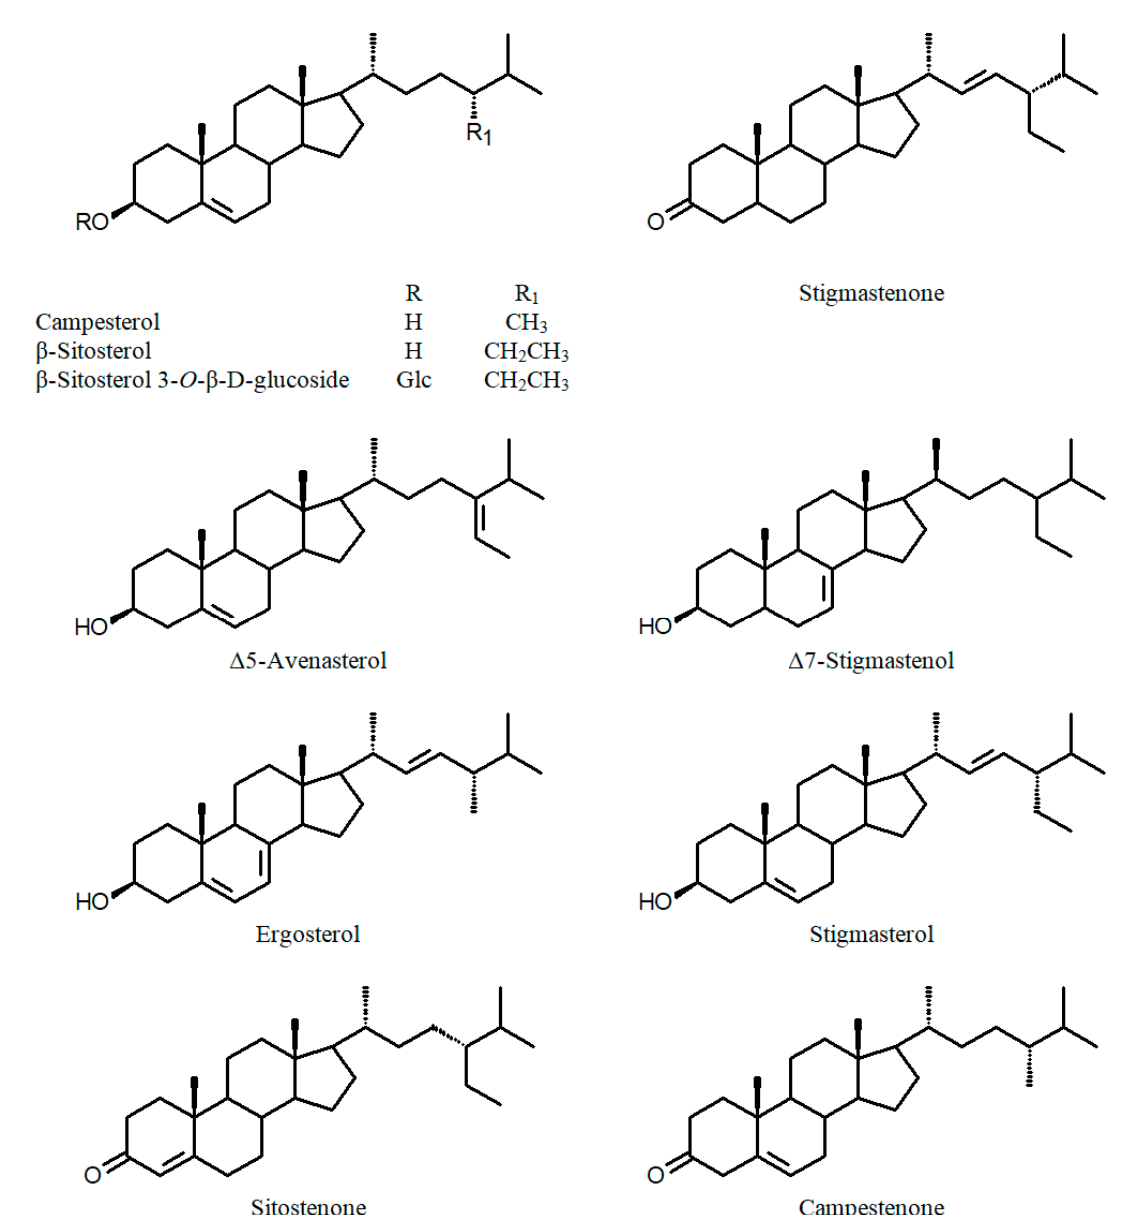
Figure 6. Chemical structures of sterols of the genus Cuphea .